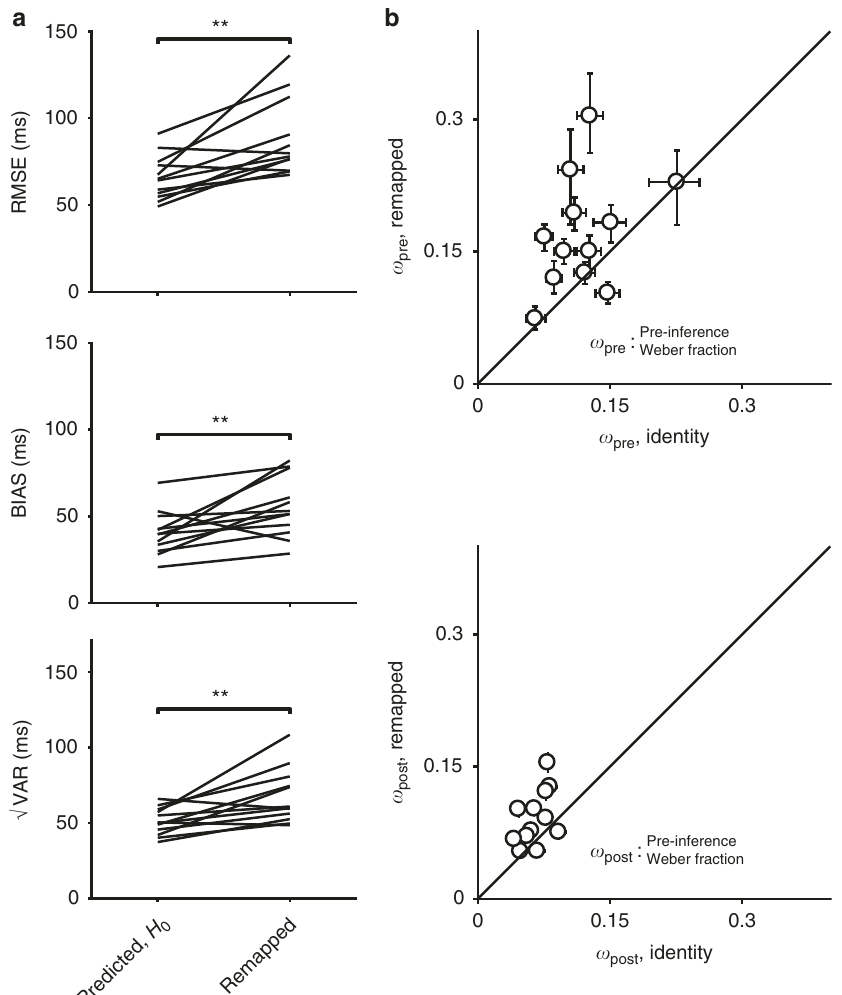
Fig. 5 Summary of subjects ’ behavior in the time measurement and production task, gain = 0.75. All results are shown using the same format as in Fig. 3 with the only exception that the remapped context corresponds to the gain of 0.75. a Comparison of RMSE (top), BIAS (middle), and √ VAR (bottom) for all subjects. Most subjects had higher RMSE, BIAS, and √ VAR than was predicted assuming no additional MTN (**: p < 0.01, Wilcoxon two-sided signed- rank test). The same identity context data was used as a comparison for both gain = 0.75 and gain = 1.5. b Fitted model parameters. Most subjects were fi t with higher values of w pre (top) in the remapped context, re fl ecting additional reliance on prior information consistent with a late inference strategy. There was also a more modest increase in w post for the remapped context (bottom) for most